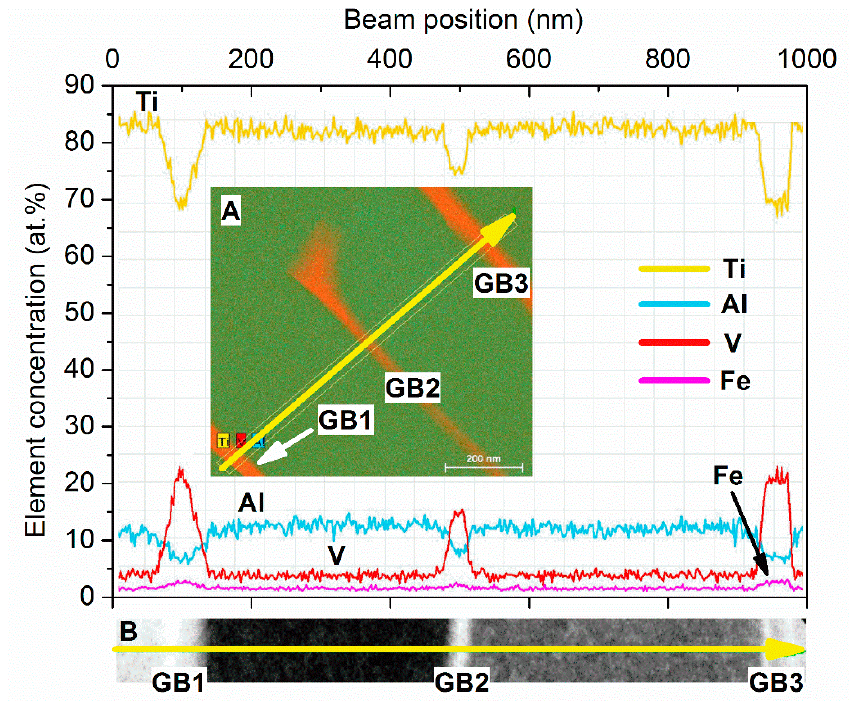
Figure 6. Element concentration (in at.%) obtained by EDS line-scan analysis. Inset A: location of the scanned line (arrow) on the sample. Inset B: scanned line (arrow) with the position of grain boundary (GB) marked.